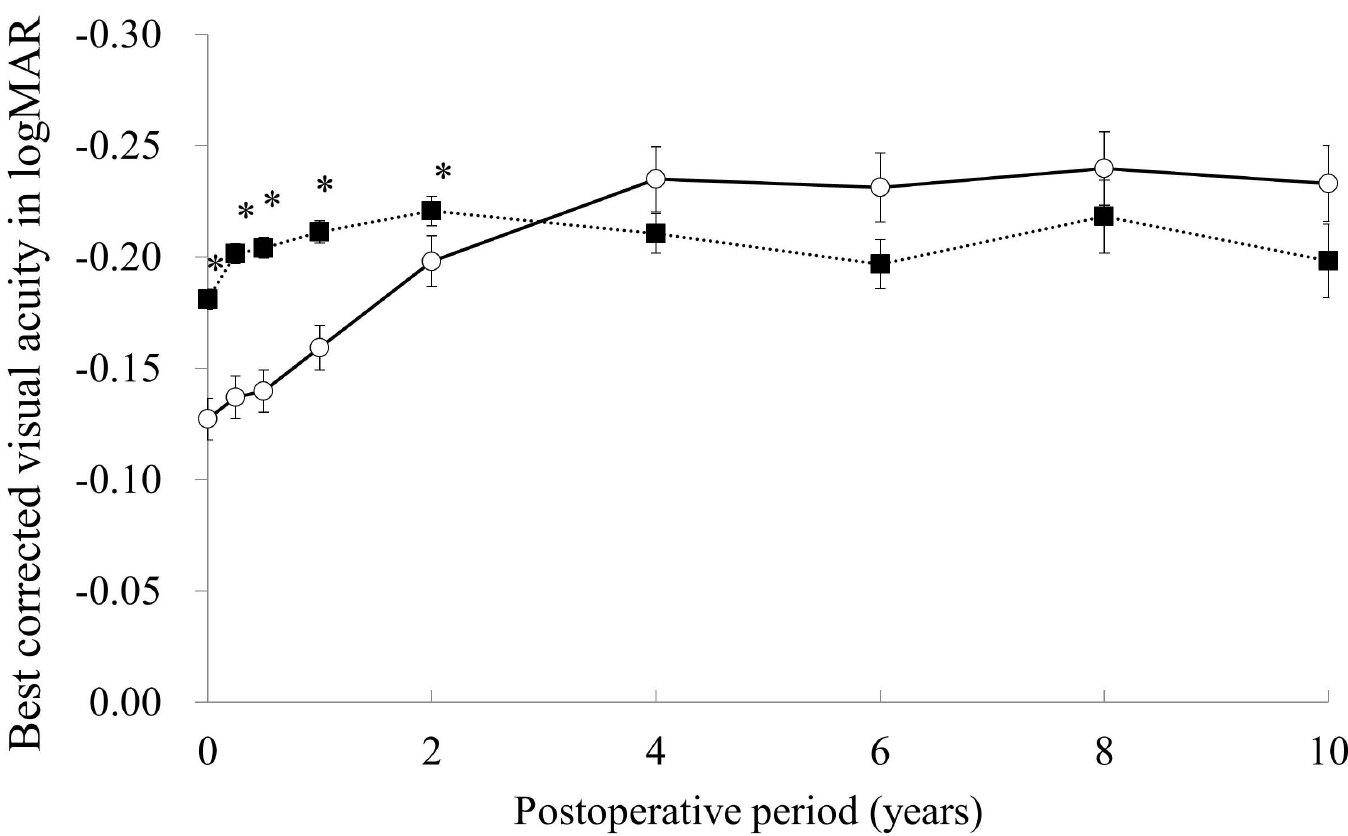
Fig 2. Time courses of the averageand 95% confidence intervals of best spectacle-correctedvisual acuity in the laser in situ keratomileusis (closed square) and photorefractive keratectomy (open square) groups. * p <